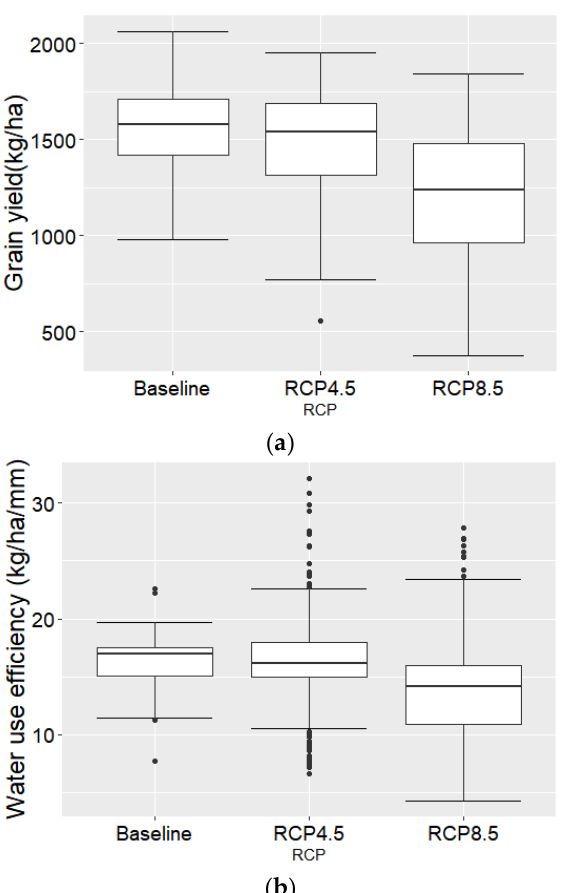
Figure 6 . Impact of climate change on maize grain yield ( a ) and water use efficiency ( b ) under RCP 4.5 and 8.5 .